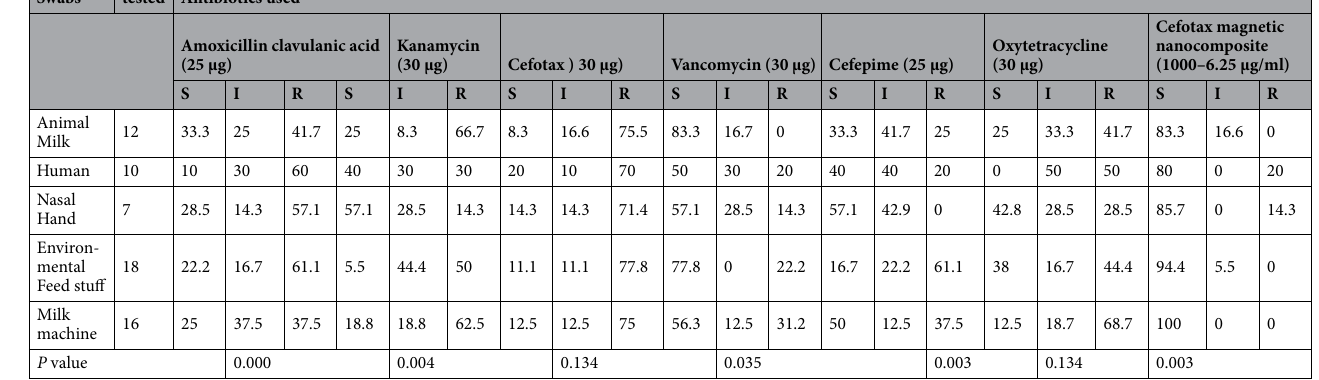
Table 3. In -vitro antibiotic sensitivity pattern of S. aureus isolates from animal, human and environmental samples. R resistant, I intermediate, S sensitive.